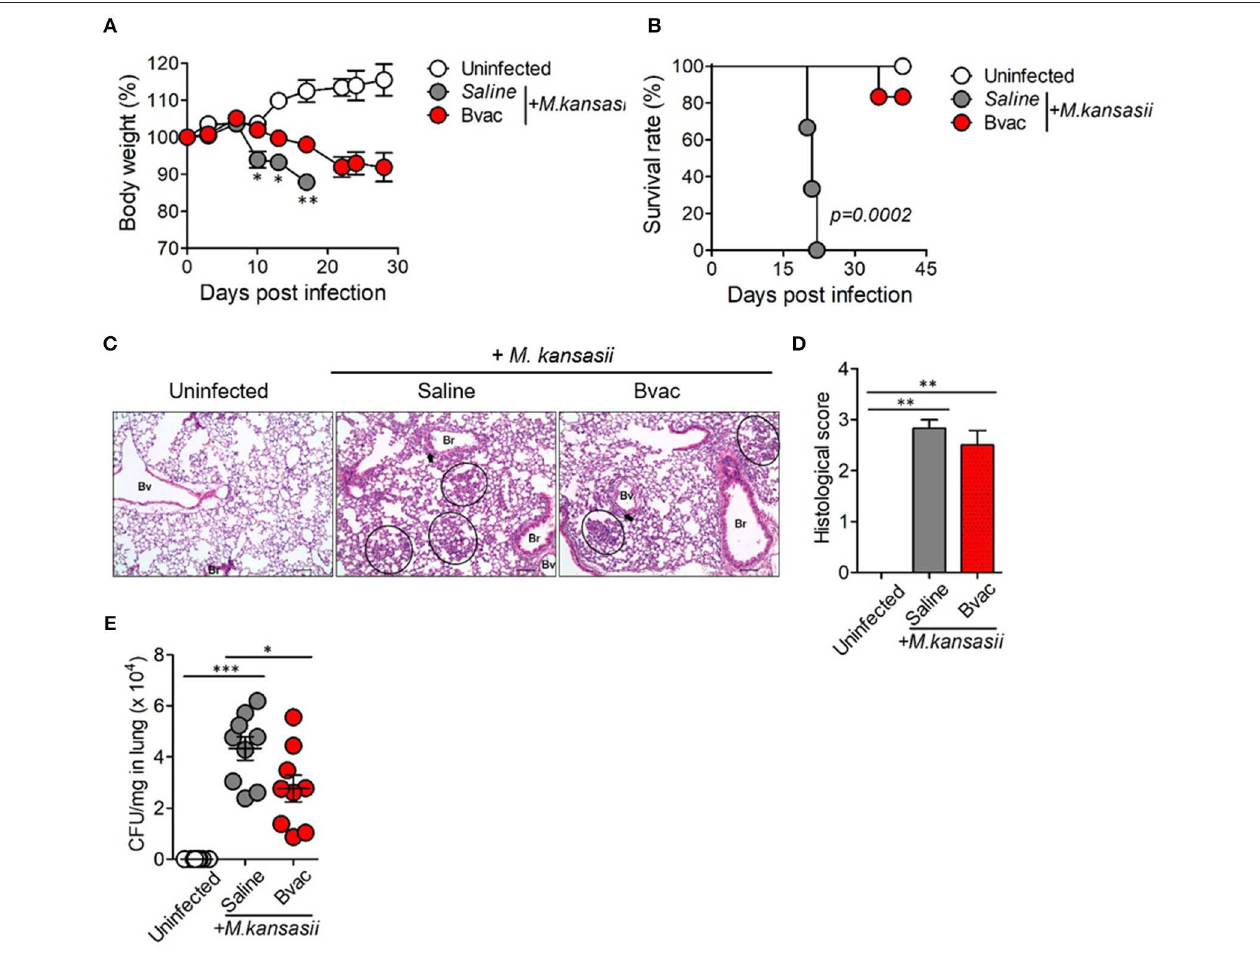
FIGURE 4 | Bvac has therapeutic effect on mice infected with M. kansasii . To evaluate therapeutic efficacy of Bvac, mice were infected with 10 7 CFU of M. kansasii per mouse, and Bvac was administered via tail vein injection at day 3 and 7 post infection ( n = 5 for uninfected, n = 6 for saline and Bvac group). After 14 days following M. kansasii infection, histology and bacterial CFU were determined from lung. (A) Body weights of mice are shown, ANOVA. * p < 0.05, ** p < 0.01, M. kansasii vs. Bvac + M. kansasii . (B) Survival rate. Log-rank test. (C) Representative hematoxylin and eosin staining of lung sections from each group of mice (scale bar = 100 µ m). Bv (Blood vessel), Br (Bronchus), circle indicates interstitial necrotizing inflammatory foci, and arrow is perivascular inflammatory cell infiltration. (D) Histological scores of the lung sections. (E) CFU of M. kansasii from lung homogenates. ANOVA. * p < 0.05, *** p <